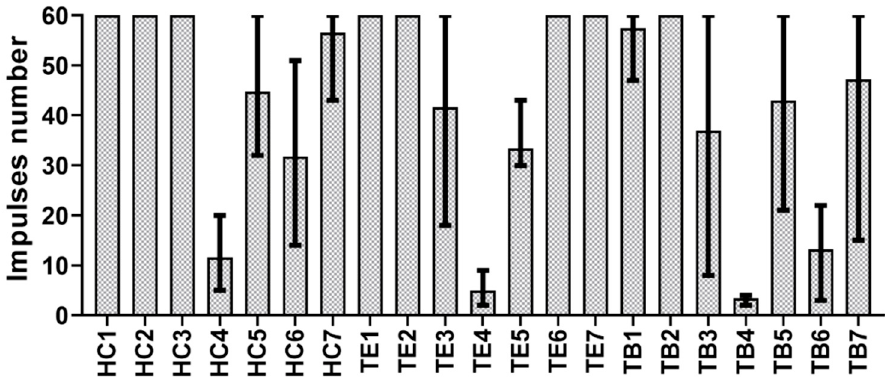
Figure 5. Number of impulses needed for retrieval with each luting agent-bridge combination.